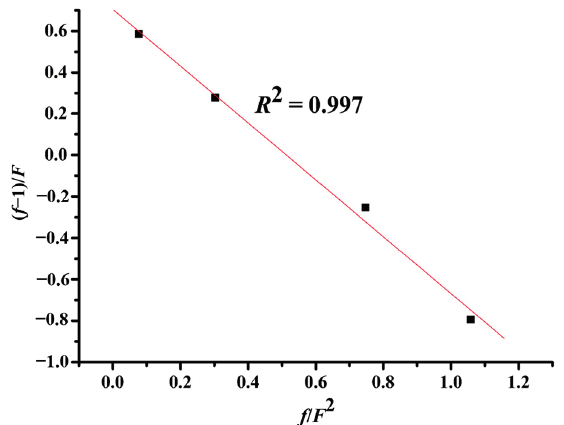
Figure A4. Plot of ( f − 1)/ F versus f / F 2 with least-squares regression line for HBM and NMD copolymerization.